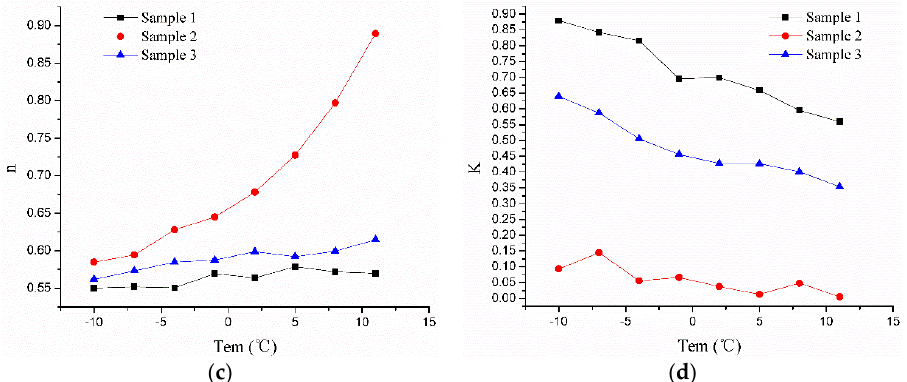
Figure 3. Rheological properties with temperature response curves of three kinds of solid-free polymer drilling fluid (SFPDF). ( a ) Apparent viscosity with the temperature response curve; ( b ) Yield stress with the temperature response curve; ( c ) Flow behavior index with the temperature response curve; and ( d ) Consistency coefficient with the temperature response curve. Table 5. Rheological properties with temperature characteristic equations of three kinds of SFPDF. Parameter